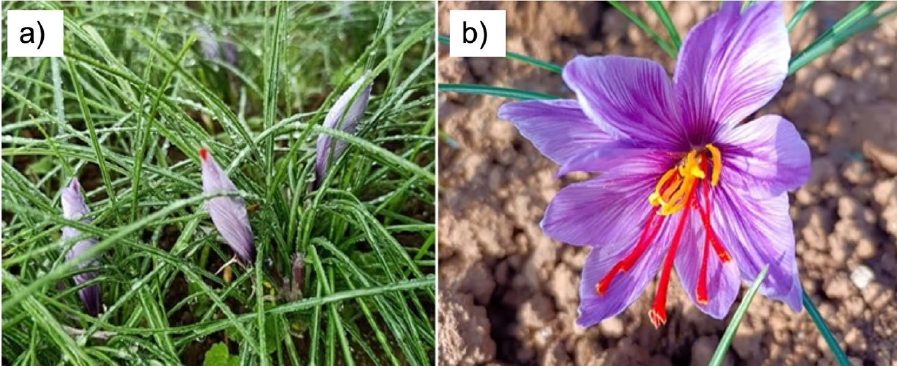
Fig. 1: Flower of saffron collected following the Italian good practices, in bud early in the morning (a), before the flower blooms and stigmas are exposed to sunlight